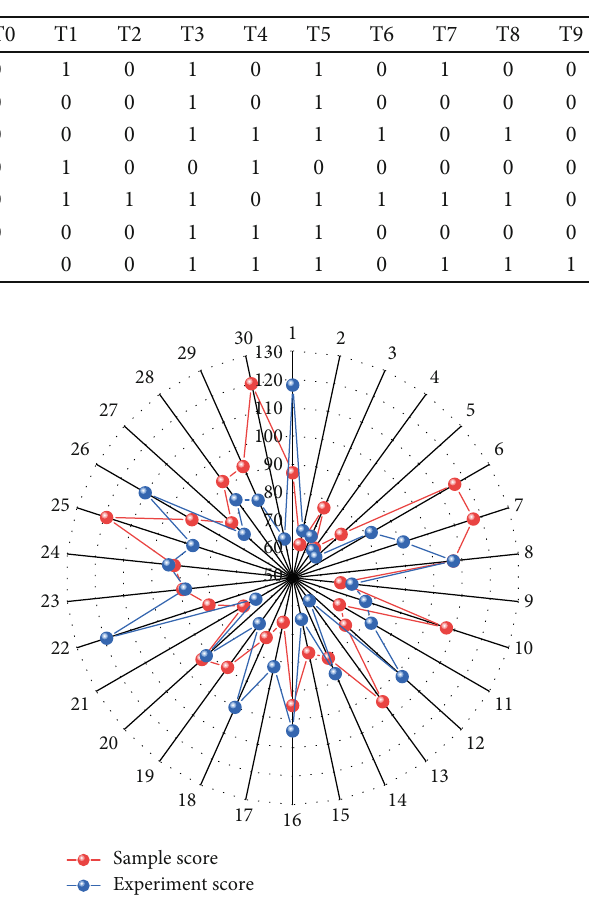
Table 1: Partial table for calculation of e ff ective time.